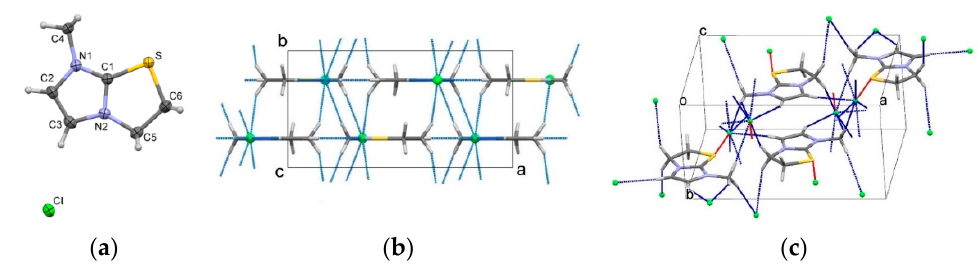
Figure 3. ( a ) Molecular structure of 4a with the atomic numbering scheme; ( b ) projection of 4a down the c-axis, ( c ) packing diagram of 4a . Hydrogen bonds are marked by blue dotted lines and the Cl···S electrostatic interaction by red lines.